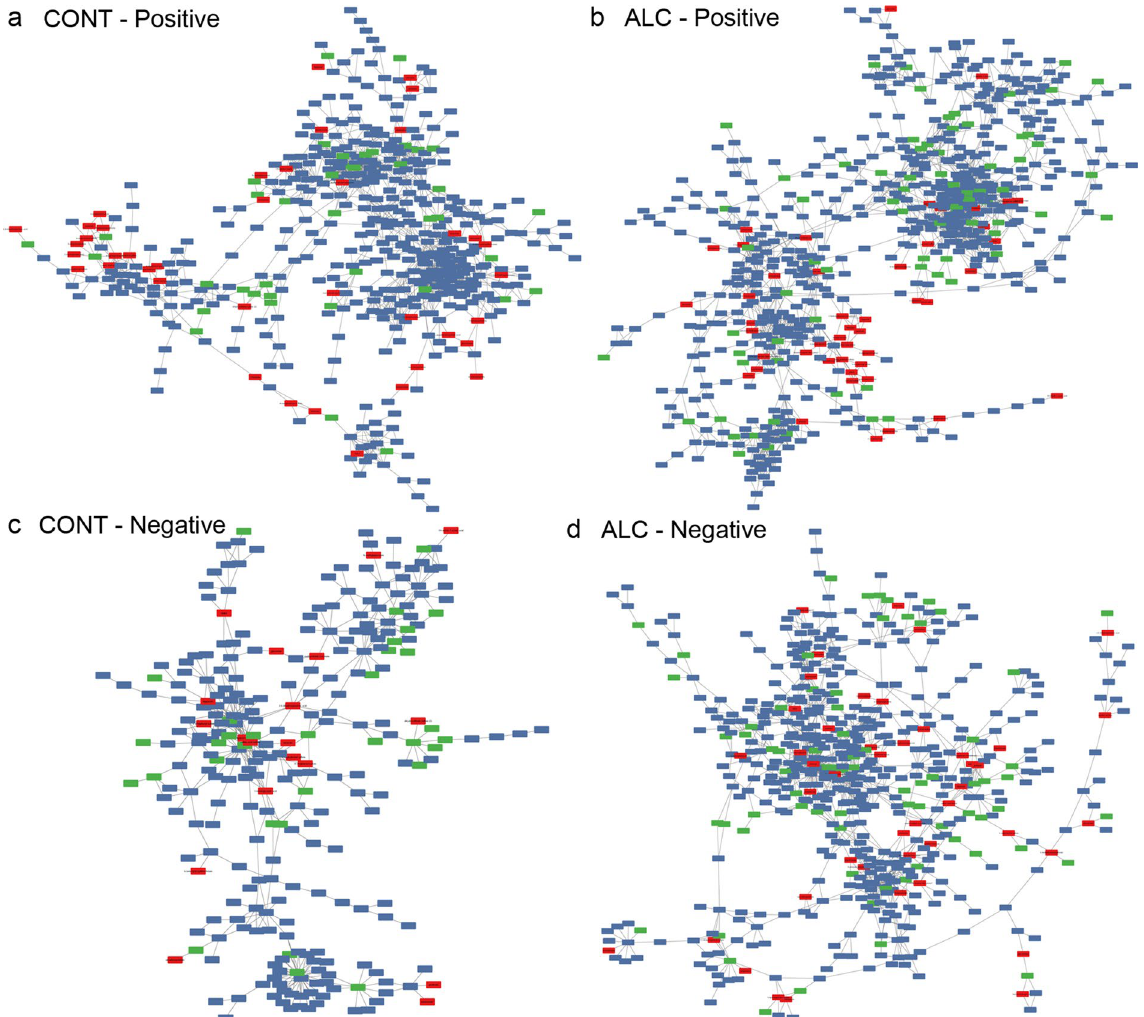
Figure 3. Correlation analysis identifies microbial metabolite networks that are at statistical equilibrium within maternal plasma. Images were generated in Cytoscape (version 3.7.2) using R-Cy3 (version 2.6.3), wherein the network edges represent between-node Spearman’s correlations > 0.90 ( a , b ) or ≥ − 0.90 ( c , d ); distance between nodes indicates strength of interaction. Colors as in Fig. 2; red indicates MDPs, blue indicates endogenous compounds, and green are unknown compounds. ( a ) Positive correlation network of metabolites in control (CONT) maternal plasma having Spearman’s values ≥ 0.90. ( b ) Positive correlation network of metabolites in alcohol-exposed (ALC) maternal plasma having Spearman’s values ≥ 0.90. ( c ) Negative correlation network of metabolites in control (CONT) maternal plasma having Spearman’s values ≥ − 0.90. ( d ) Negative correlation network of metabolites in alcohol-exposed (ALC) maternal plasma having Spearman’s values ≥ − 0.90. Sample size is n = 9 control and n = 8 alcohol-exposed